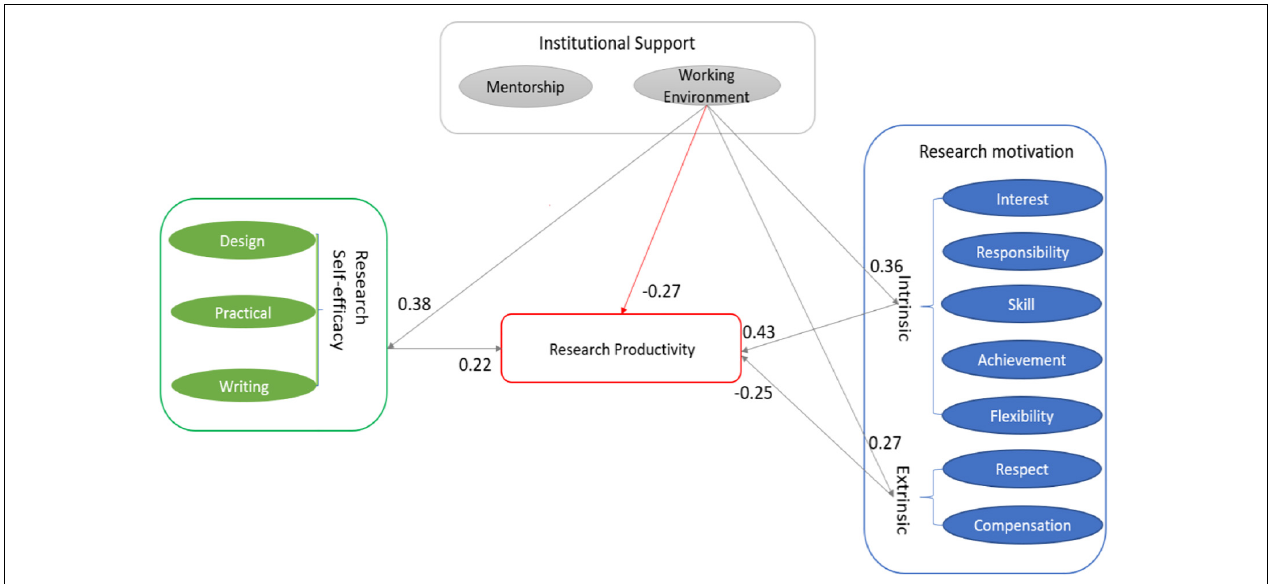
FIGURE 5 | The influence on teachers’ research productivity.